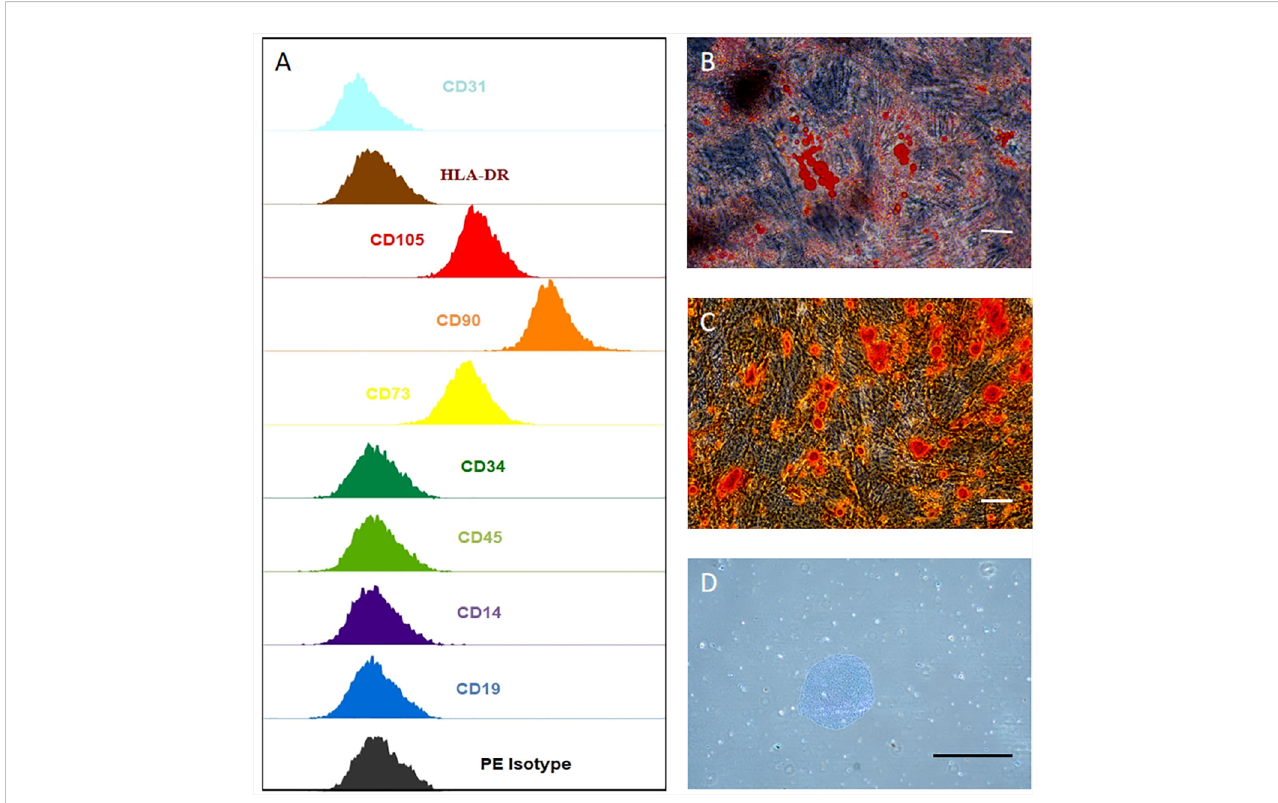
FIGURE 2 hUCMSCs surface markers detected by fl ow assay and three-lineage (adipogenic, osteogenic, chondrogenic) differentiation ability detected by immunocytochemistry. (A) the negative expression of surface markers CD14, CD19, CD31, CD34, CD45, HLA-DR of hUCMSCs; and the positive expression of surface markers CD73, CD90, CD105 of hUCMSCs, antibody binding dye is PE; (B) Oil red O staining to analyze adipogenic differentiation of hUCMSCs; (C) Alcian blue staining to explore chondrogenic differentiation of hUCMSCs; D: Alizarin red staining to analyze osteogenic differentiation of hUCMSCs.The scale bar = 50 m m in (B) and 200 m m in (C, D) .